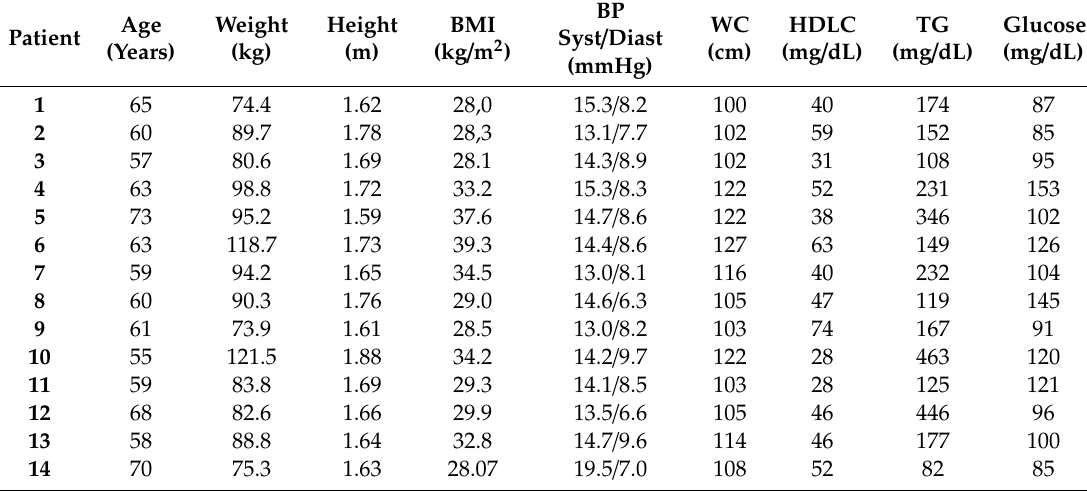
Table 1. Individual anthropometric and clinical characteristics of